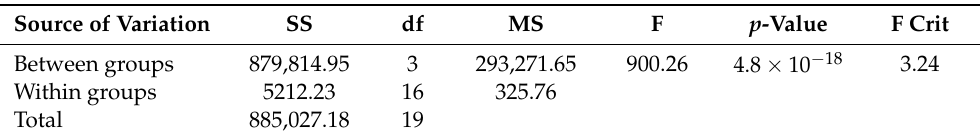
Table 11. Resulting ANOVA table for hybrid glass–carbon–glass laminates under testing temperatures of 25–100 ◦